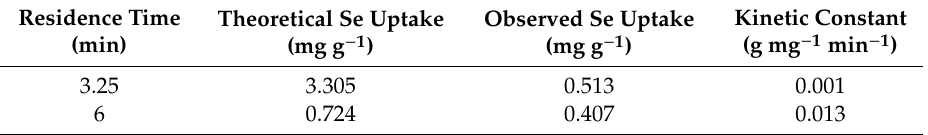
Table 1. Equilibrium concentration and kinetic constants from 2nd order kinetic model fitting.